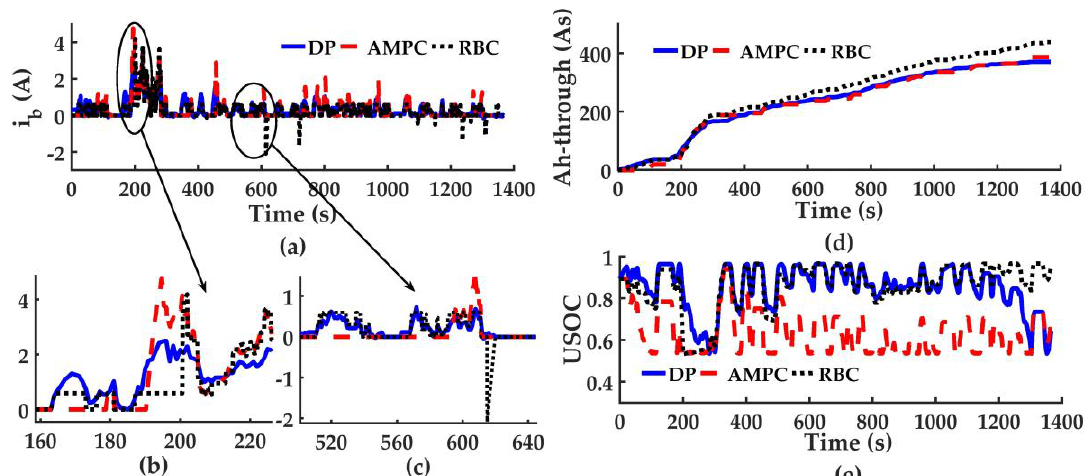
Figure 12. HESS states comparison under UDDS with DP, AMPC and RBC. ( a ) LiB current comparison; ( b ) LiB current comparison between 160 s and 220 s; ( c ) LiB current comparison between 500 s and 640 s; ( d ) LiB Ah-throughput comparison; ( e ) USOC comparison.